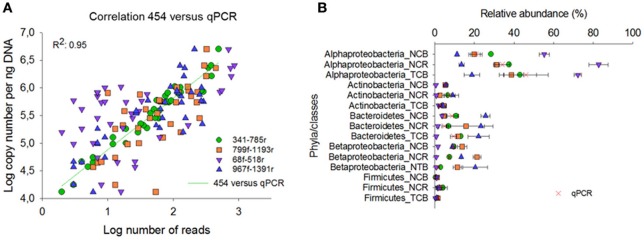
Comparison of the relative abundance of different phyla and classes in the soil samples obtained by 454 pyrosequencing (A) and qPCR (B). NCB, non-contaminated bulk soil; NCR, non-contaminated rhizosphere soil; TCB, TNT-contaminated bulk soil.